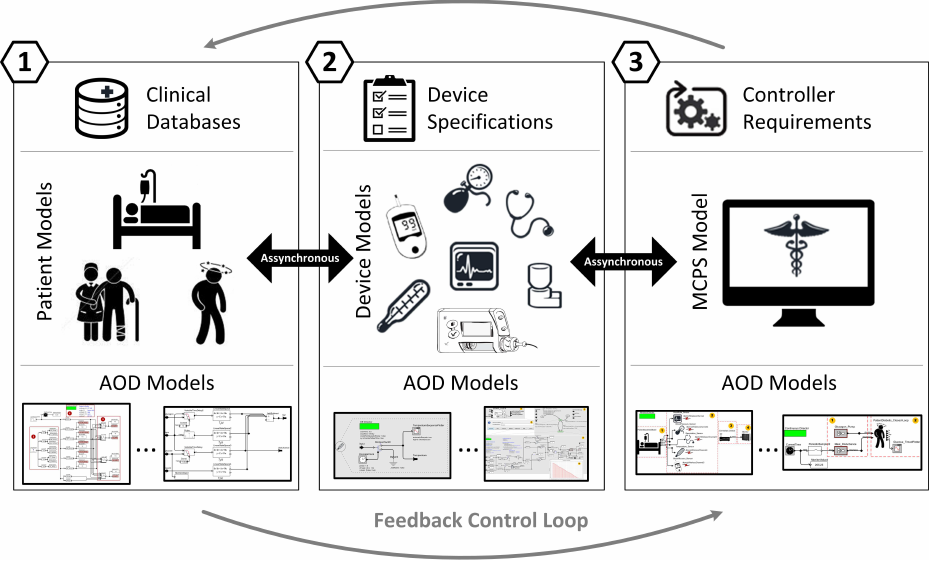
Figure 13. A Model-Based Architecture for MCPS.